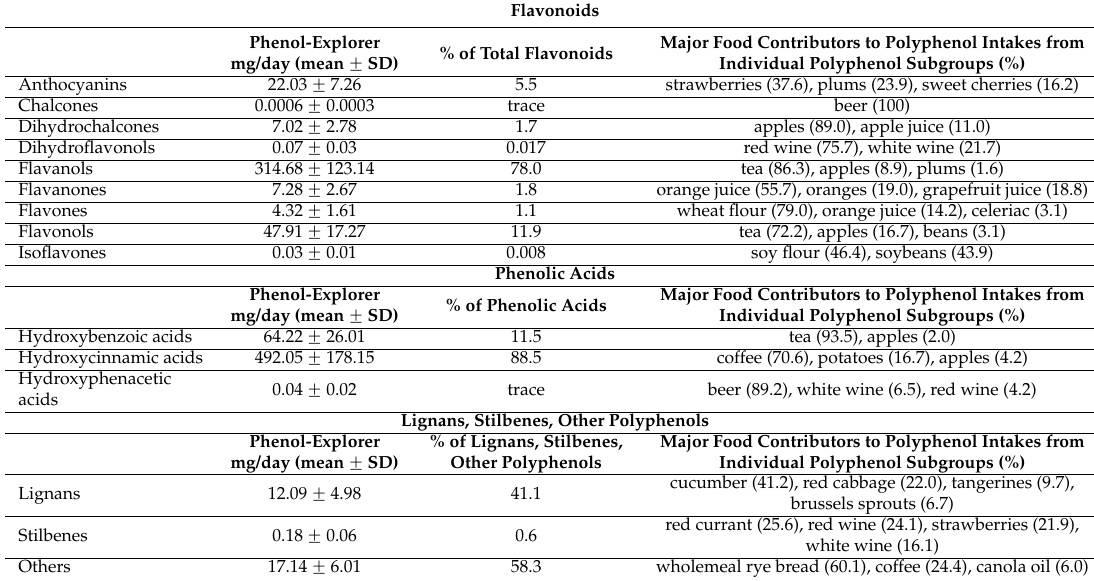
Table 5. Dietary polyphenol intakes calculated with the Phenol-Explorer database and their major food contributors ( n =